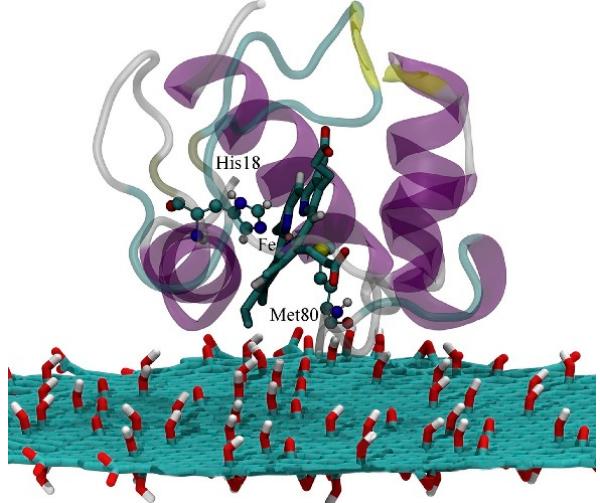
Figure 14. The electron transfer pathway of Cyt c on the graphene oxide (GO) surface. Reprinted with permission from [207]. Copyright (2018) Elsevier.